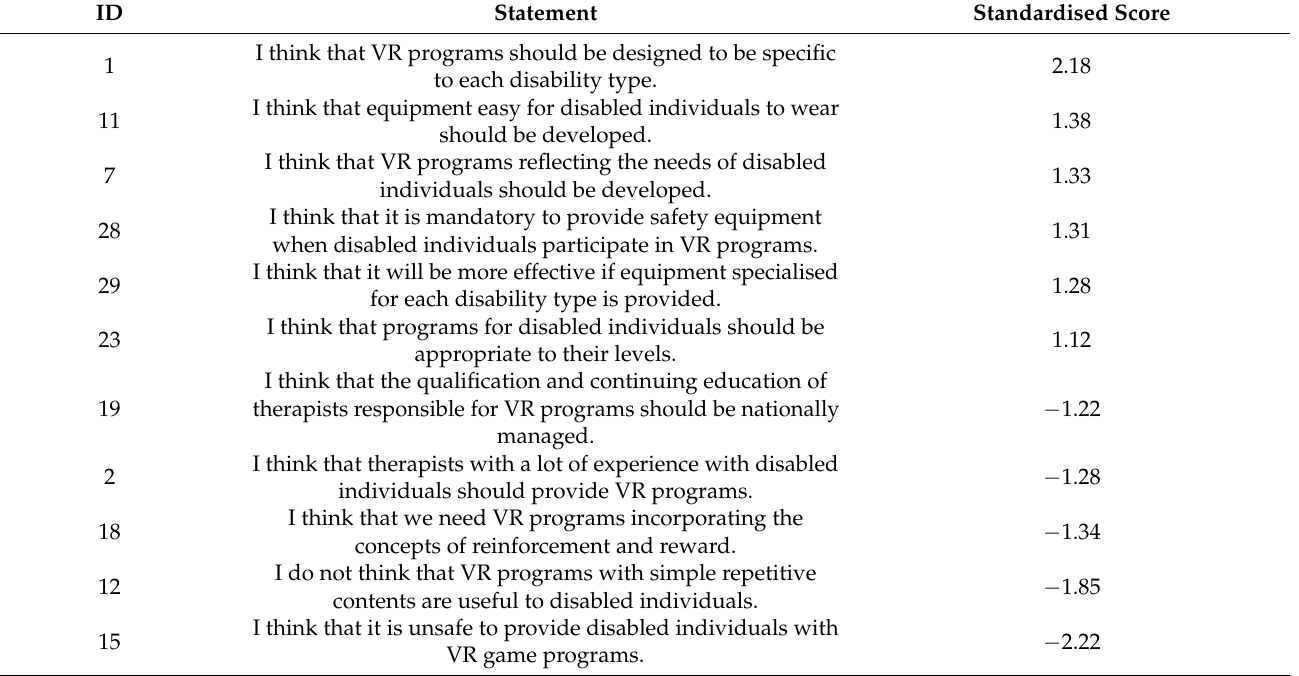
Table 8. Type 3 statements and standardised scores ( ± 1.00 and